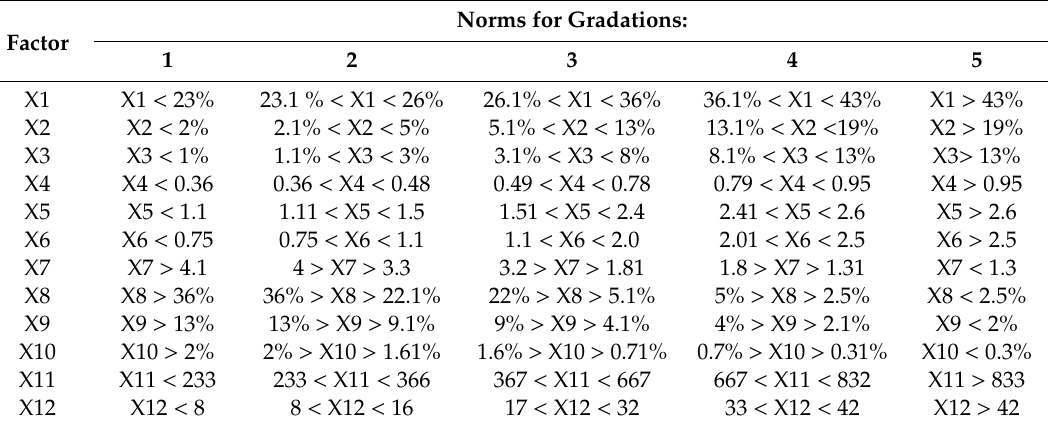
Table 3. DL31 norms.